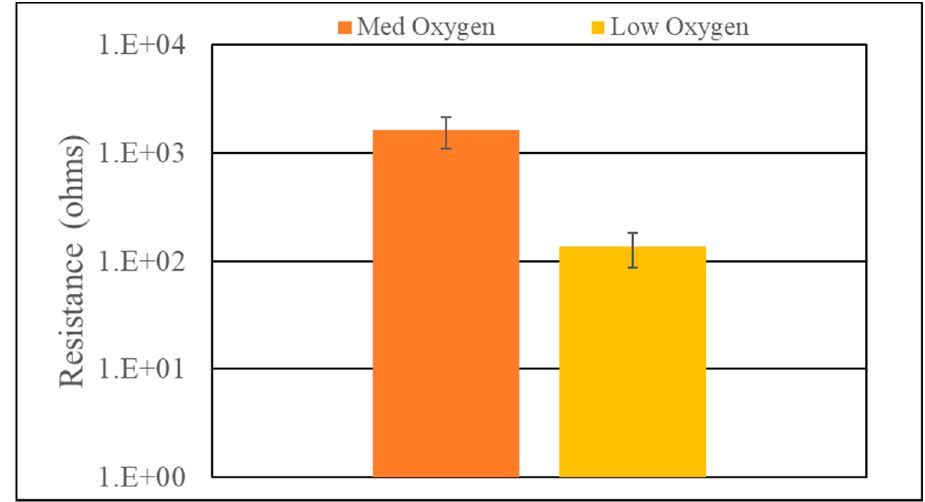
Figure 22. Final resistance value with one standard error in resistance and pressure for med and low O2 AL6061 powders.